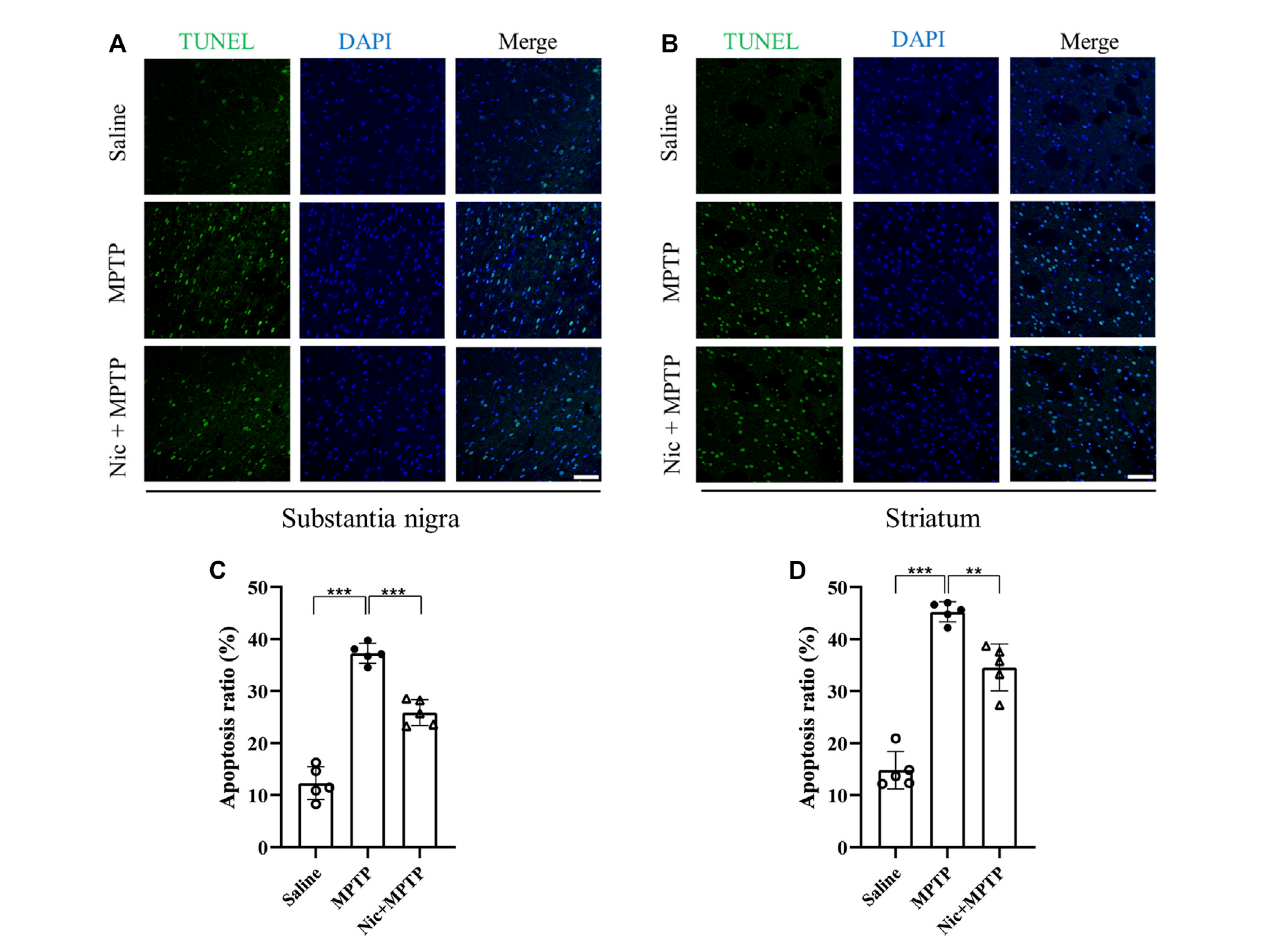
FIGURE 2 Effects of nicotine on apoptosis in the substantia nigra and striatal brain regions of MPTP-treated mice. Representative image of TUNEL signals (green panel),cellnuclei(bluepanel)andco-localization(mergepanel)inbrainsectionsfromthesubstantianigra (A) andstriatalregions (B) ofmice.Statisticalresults onthestatusofapoptoticcellsinTUNELinthesubstantianigra (C) andthestriatalregions (D) .Scalebarat50 μ m.Dataareexpressedasmean±SEMfrom fi ve mice in each group, every point on the graph is an average from four fi xed fi elds of view for each mouse. Signi fi cant differences were determined by an unpaired Student ’ s t-test and one-way ANOVA followed by Tukey ’ s multiple comparison post hoc test * p < 0.05, ** p < 0.01, *** p <